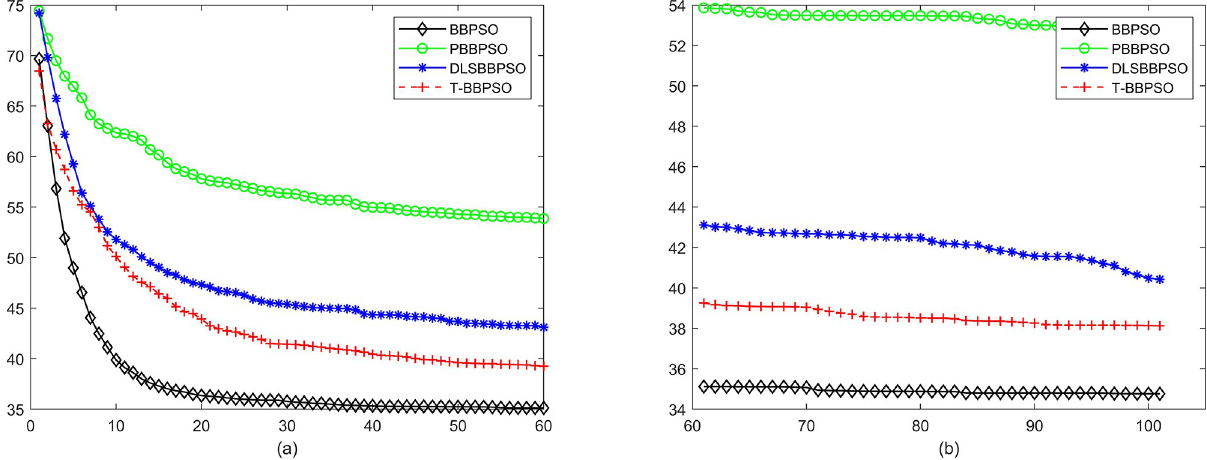
Fig 8. Comparison of convergence speed between BBPSO, PBBPSO, DLS-BBPSO and TBBPSO, f 6 , (a) iteration 0–6000, (b) iteration 6000–10000 the unit is 100 iteration.